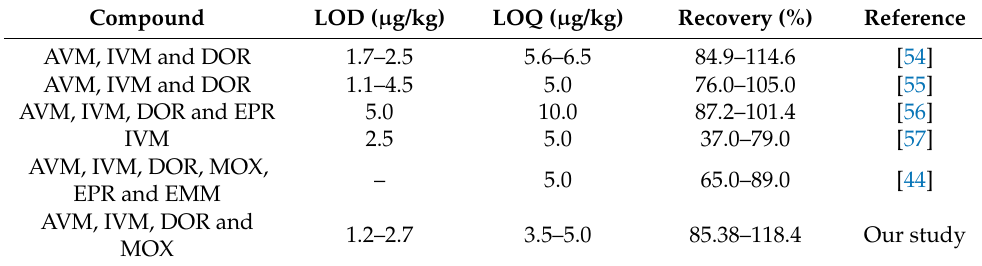
Table 5. Summary of dates validation obtained by others authors.